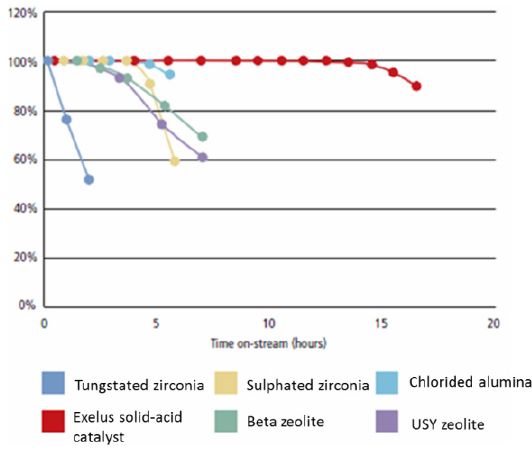
Figure 10. Different obtained yields using different solid heterogeneous catalysts of isobutane and 2-butene